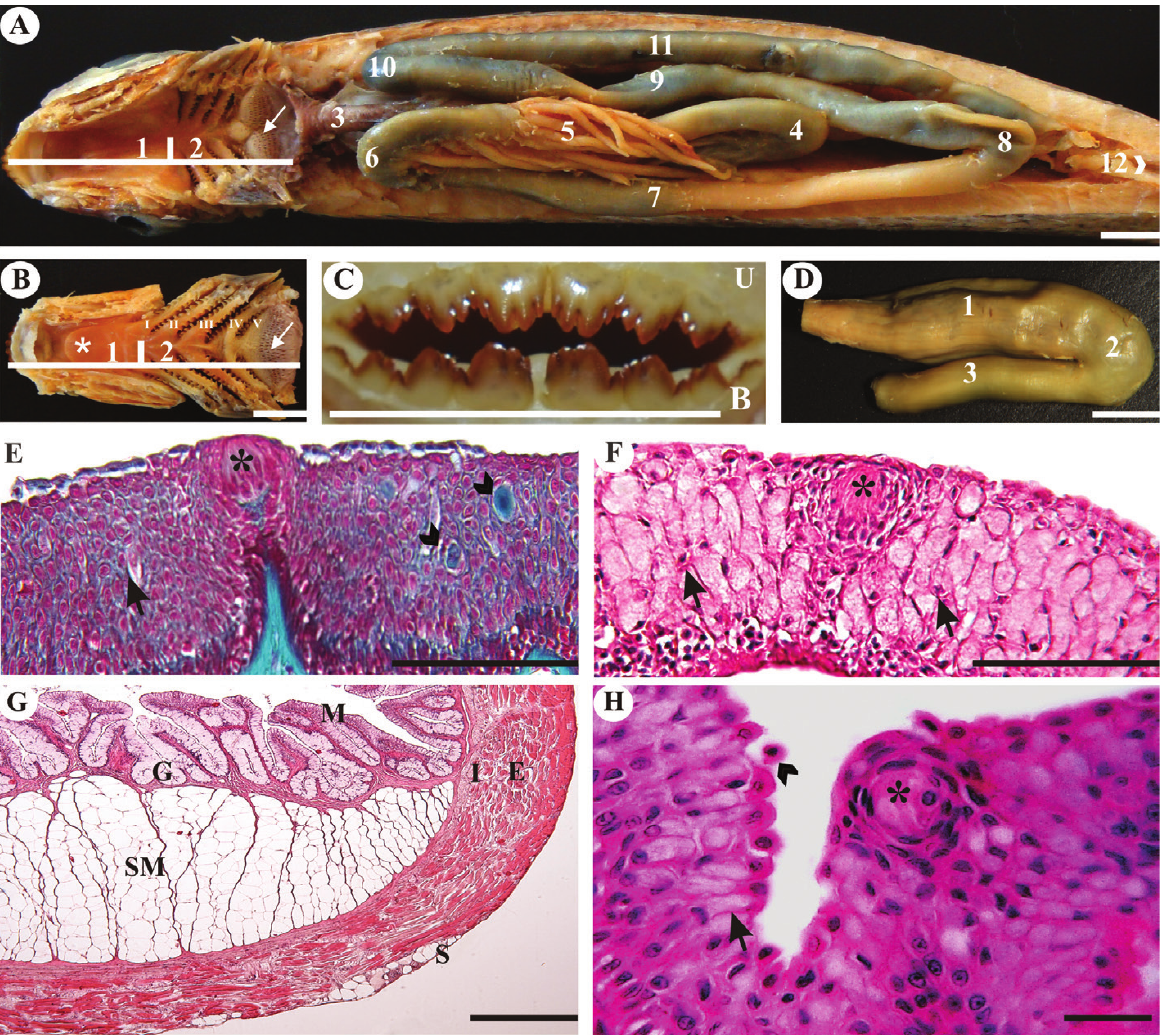
Fig. 1 - Structures of the digestive tract of S. knerii : (A). Oral cavity roof (1), oropharyngeal cavity (2), pharyngeal teeth apparatus (arrow), white bar indicates the boundary between the oral and the oropharyngeal cavities, oesophagus (3), fundic (4), pyloric caeca (5) pyloric flexure (6), cranial intestine (7), caudal flexure (8), midintestine (9), cranial flexure (10), caudal intestine (11), anus (12) (bar = 1 cm). (B). Floor of the oral cavity (1) and oropharynx (2) showing: tongue (asterisk), branchial arches (I to V), pharyngeal teeth apparatus (arrow) (bar = 1 cm). (C). View of the upper (U) and bottom (B) incisiformes rostral teeth (bar = 1 cm). (D). Side view of the stomach, showing the cardiac (1), fundic (2) and pyloric (3) regions (bar = 1 cm). (E). Longitudinal section upper lip showing: taste buds (asterisk), mucosal cell (arrow), claviform cells (arrowheads), TG (bar = 100 μm). (F). Cross section of the tongue showing: taste bud (asterisk), mucosa cell (arrow), HE (bar = 100 μm). (G). Histological organization of the oesophagus: Cross section showing mucosa (M), submucosa (SM), branched tubuloacinar oesophageal glands (G), internal muscular layer (I), external muscular layer (E), serosa (S), HE (bar = 500 μm). (H). Mucosa layer of the oesophagus showing: taste bud (asterisk), mucosa cell (arrow), epithelial cells (arrowhead), HE (bar = 100